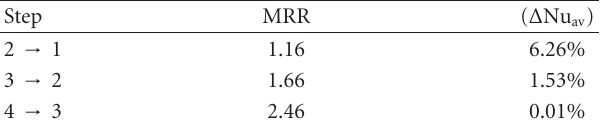
Table 5: Properties of water based Al 2 O 3 /water nanofluid at di ff erent volume fractions equaling 1% and 4% at T 0 =